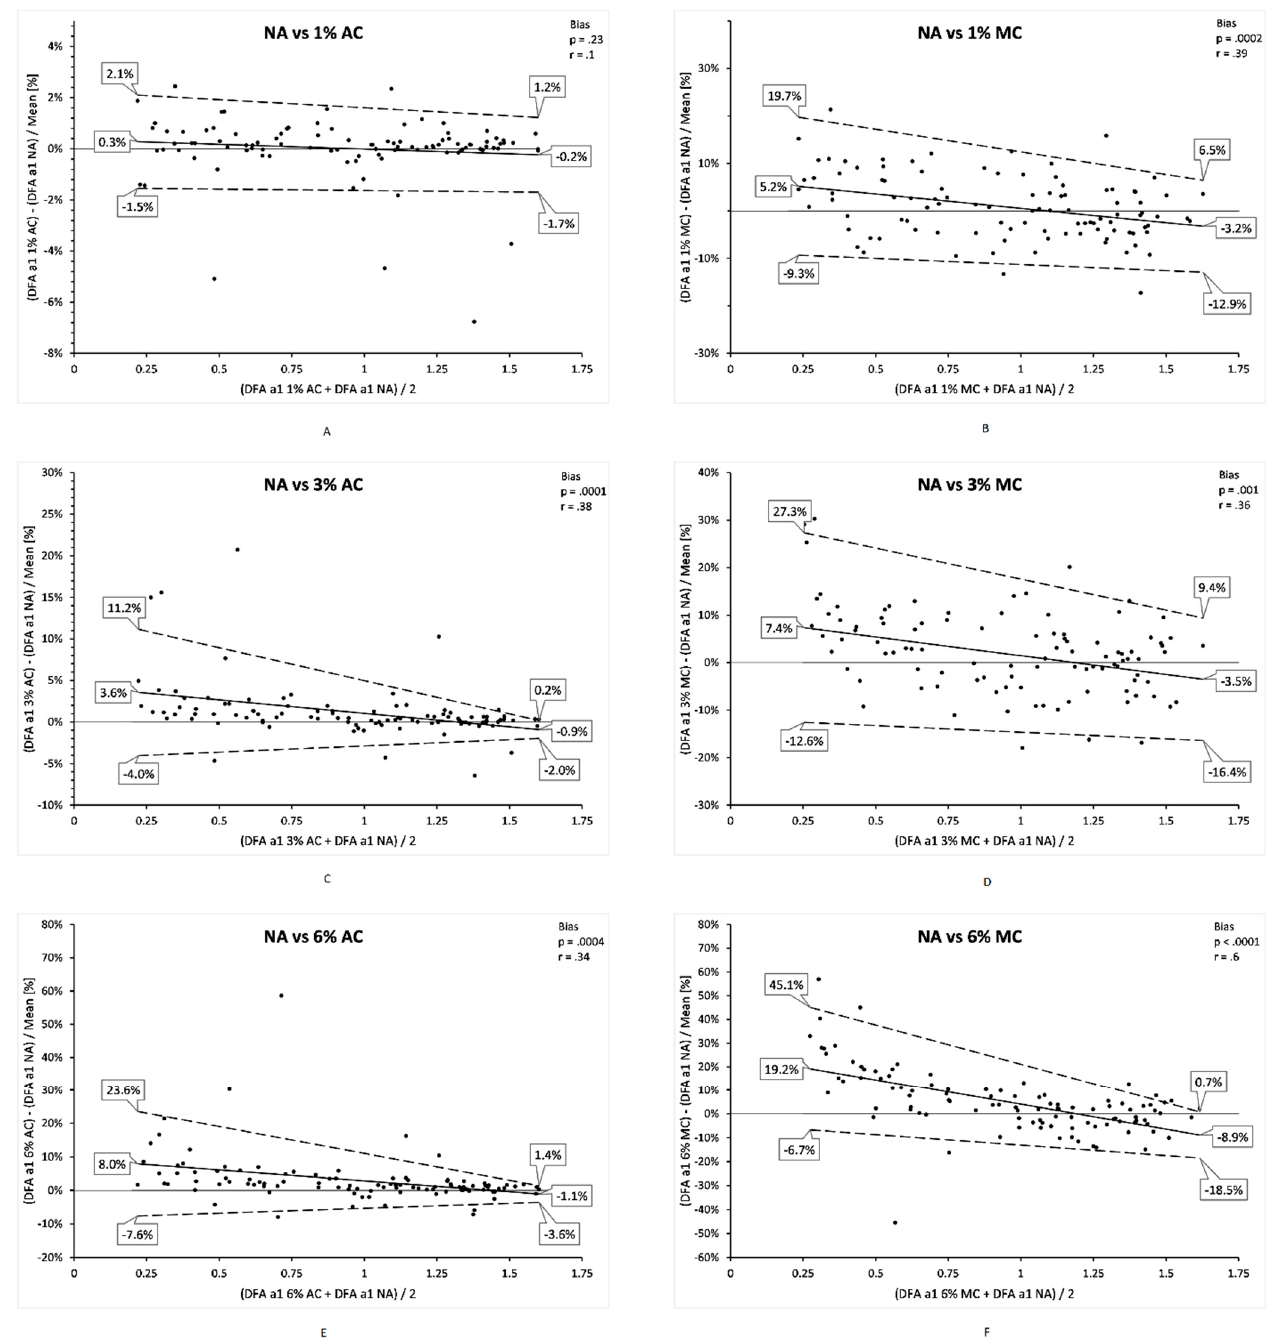
Figure 3. Bland Altman analysis of ECG derived DFA a1 NA vs. DFA a1 for each artefact condition and correction method using regression based mean and standard deviations. ( A ) vs. DFA a1 1% AC; ( B ) vs. DFA a1 1% MC; ( C ) vs. DFA a1 3% AC; ( D ) vs. DFA a1 3% MC; ( E ) vs. DFA a1 6% AC; ( F ) vs. DFA a1 6% MC. Center solid line in each plot represents the mean bias (difference) between each paired value as relative percent (difference/mean x 100). The top and bottom dashed lines are 1.96 standard deviations from the mean difference. Pearson’s r for the regression line of bias with p value shown on top right of each plot.